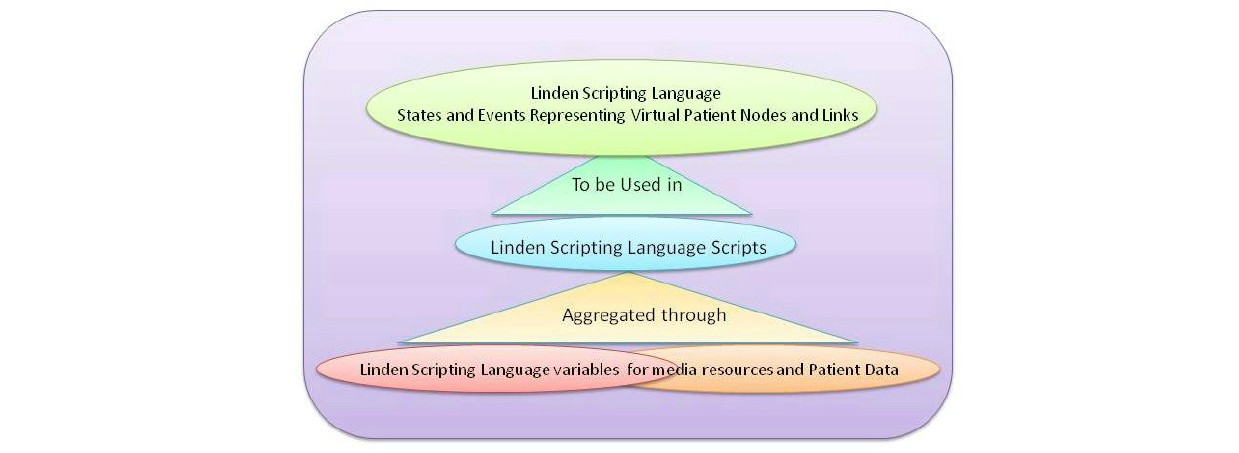
Figure 4. Second Life virtual patient development methodology.